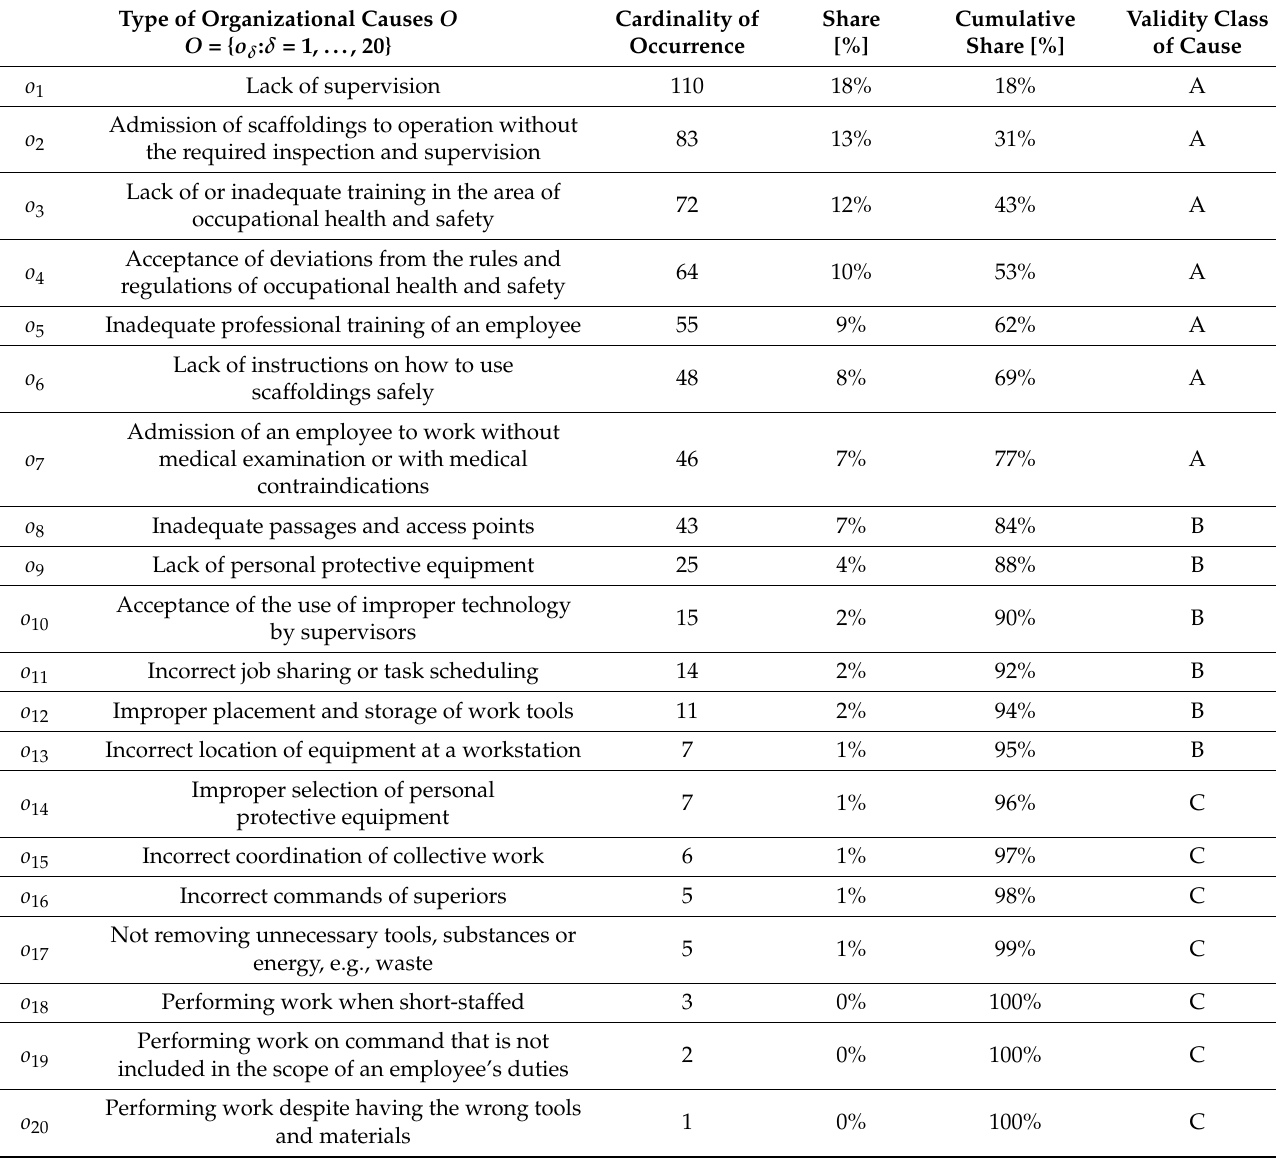
Table 3. Analyzed detailed organizational causes o δ